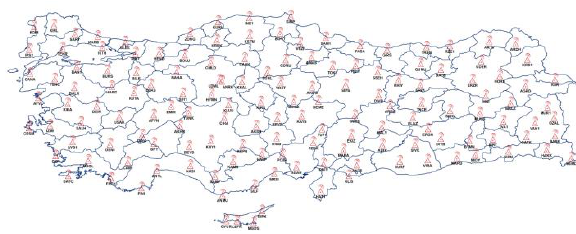
Figure 3. CORS-TR stations (146 stations, a distance of 80-100 km)